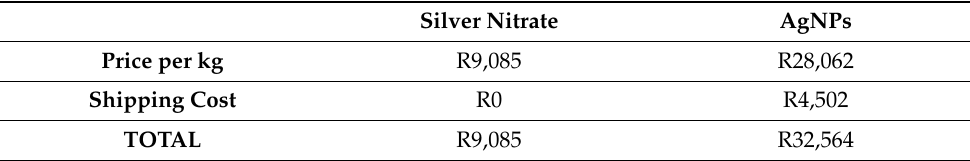
Table 4. Summary of costs related to the purchase of silver nitrate and AgNPs.